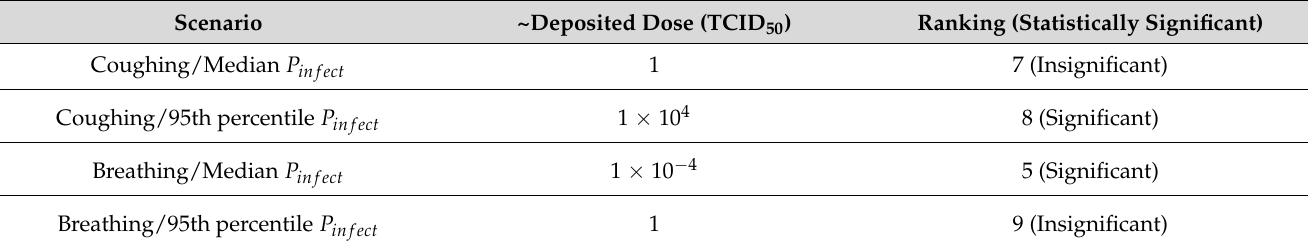
Table 4. Deposited dose and sensitivity index ranking/significance for β across multiple